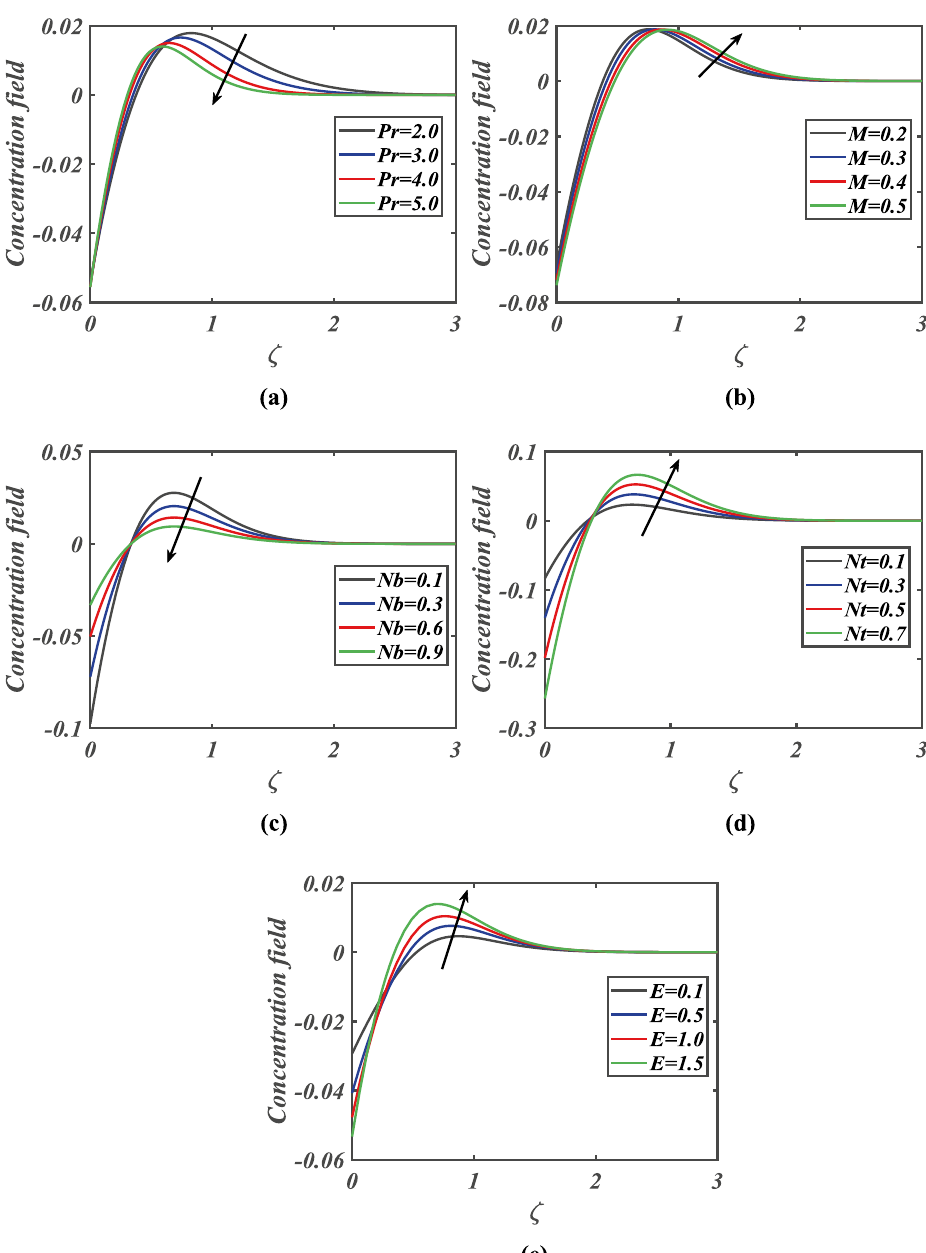
Figure 4. (a)–(e) Response of concentration φ against varied values of Pr , M , Nb , Nt and E